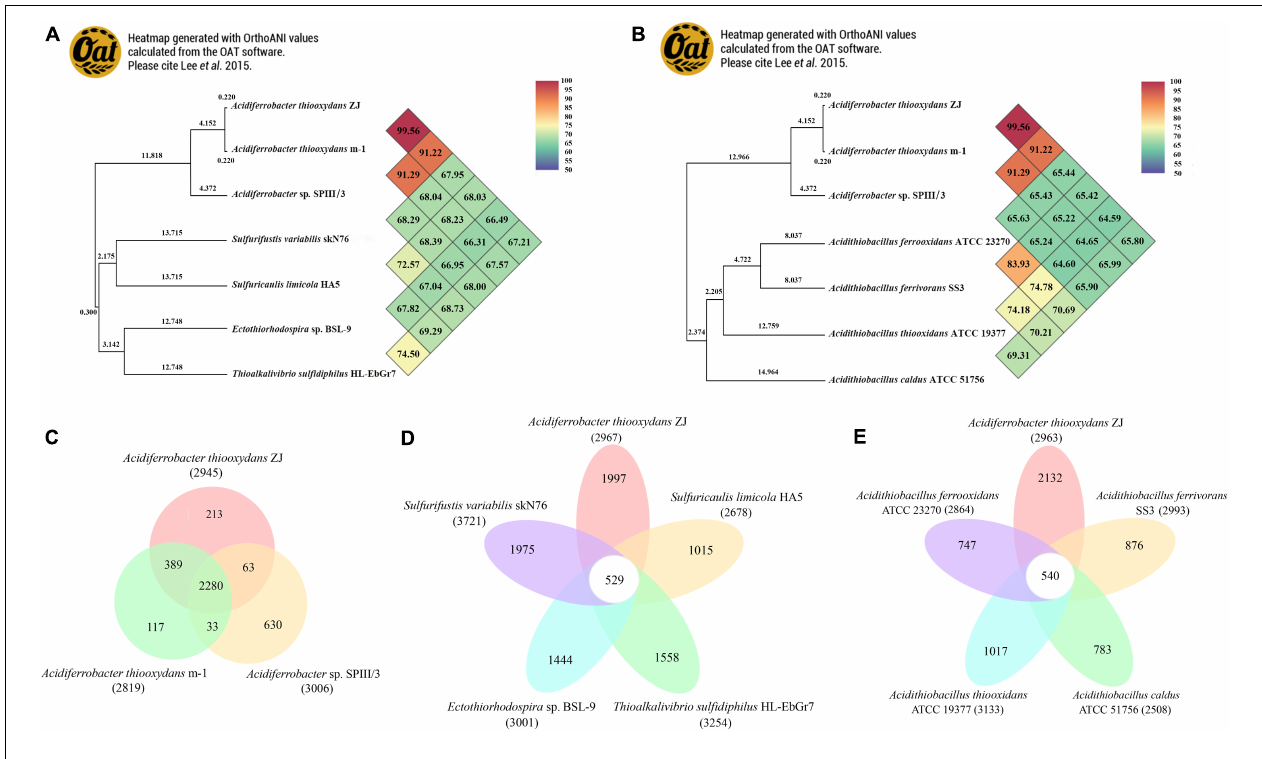
FIGURE 4 | Heatmap generated with OrthoANI values calculated using the OAT software between Acidiferrobacter and other closely related species from Ectothiorhodospiraceae (A) and Acidithiobacillaceae (B) . The numbers at each clustering node indicate the branch length. Pan-Genome analysis among Acidiferrobacter (C) , Af. thiooxydans ZJ with Ectothiorhodospiraceae (D) , and Acidithiobacillaceae (E) .